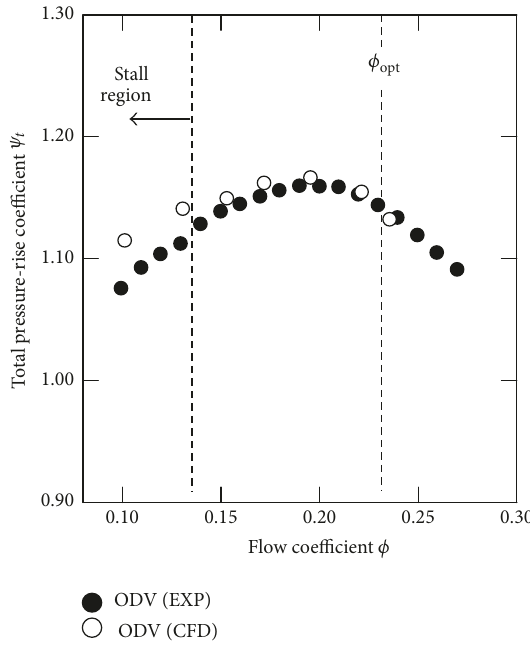
to exist between the boundary and the external atmosphere.